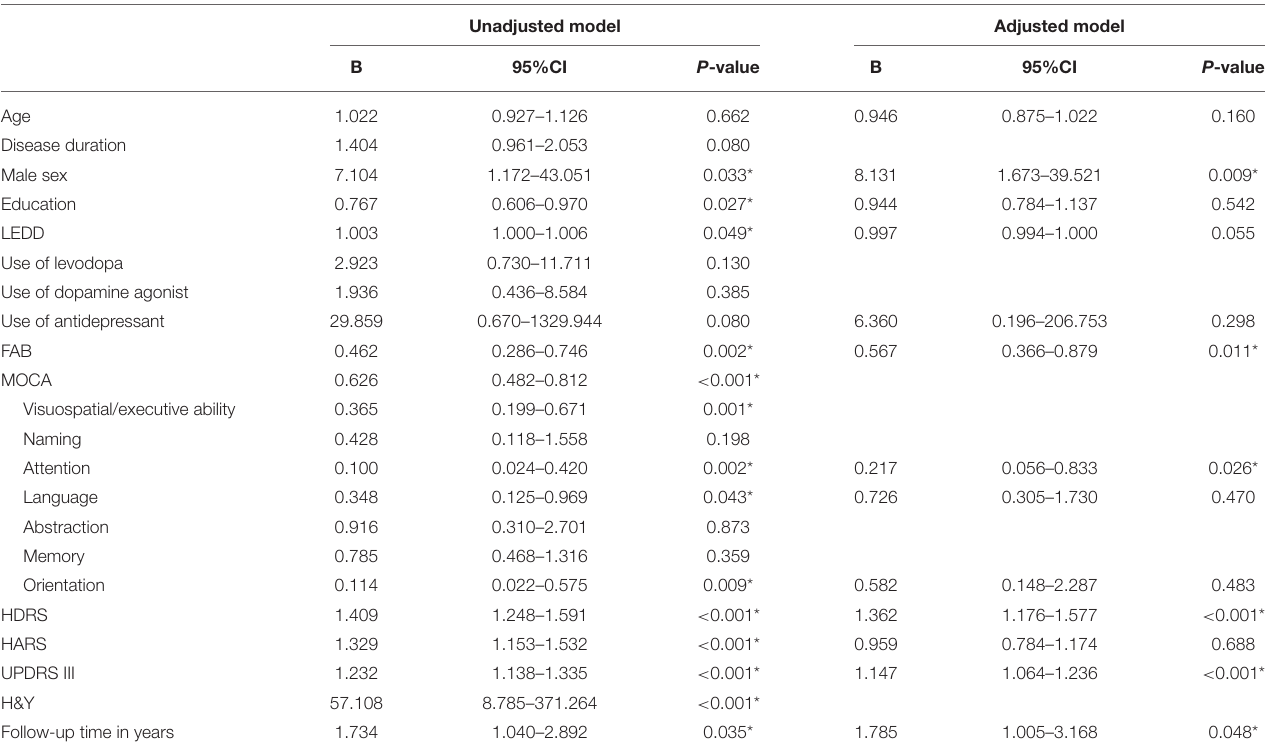
TABLE 2 | Factors associated with higher LARS scores in patients with PD.